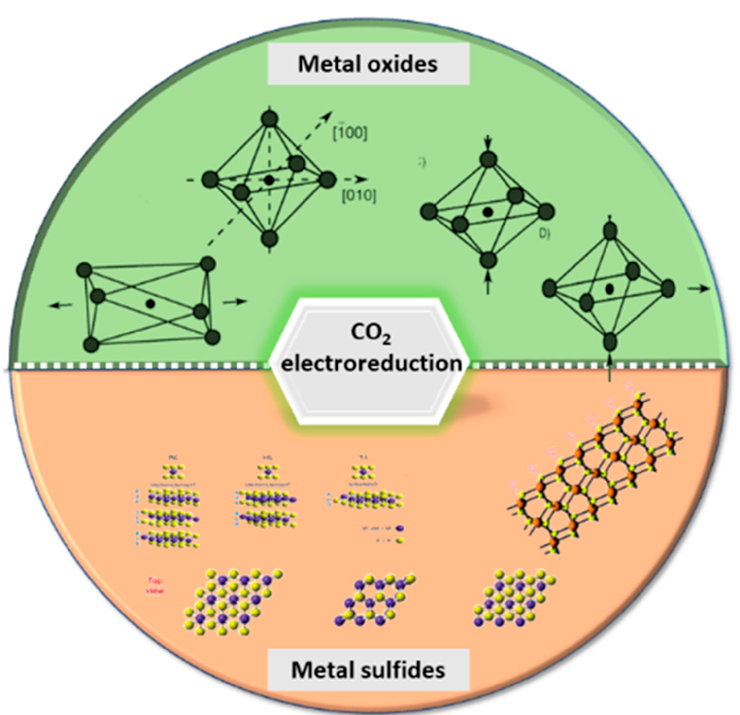
Figure 7. Overall structures of metal oxides and metal sulfides for CO 2 electroreduction.